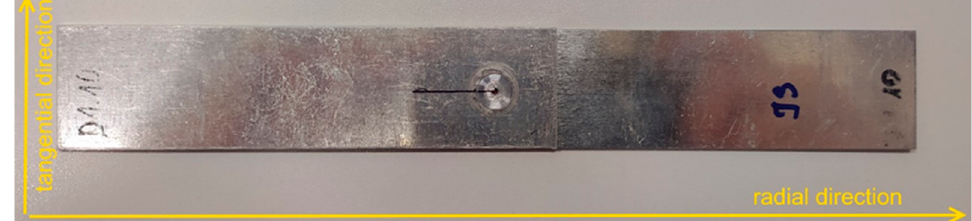
Figure 8. View of a sample of a lap joint with the directions of stress measurement marked.